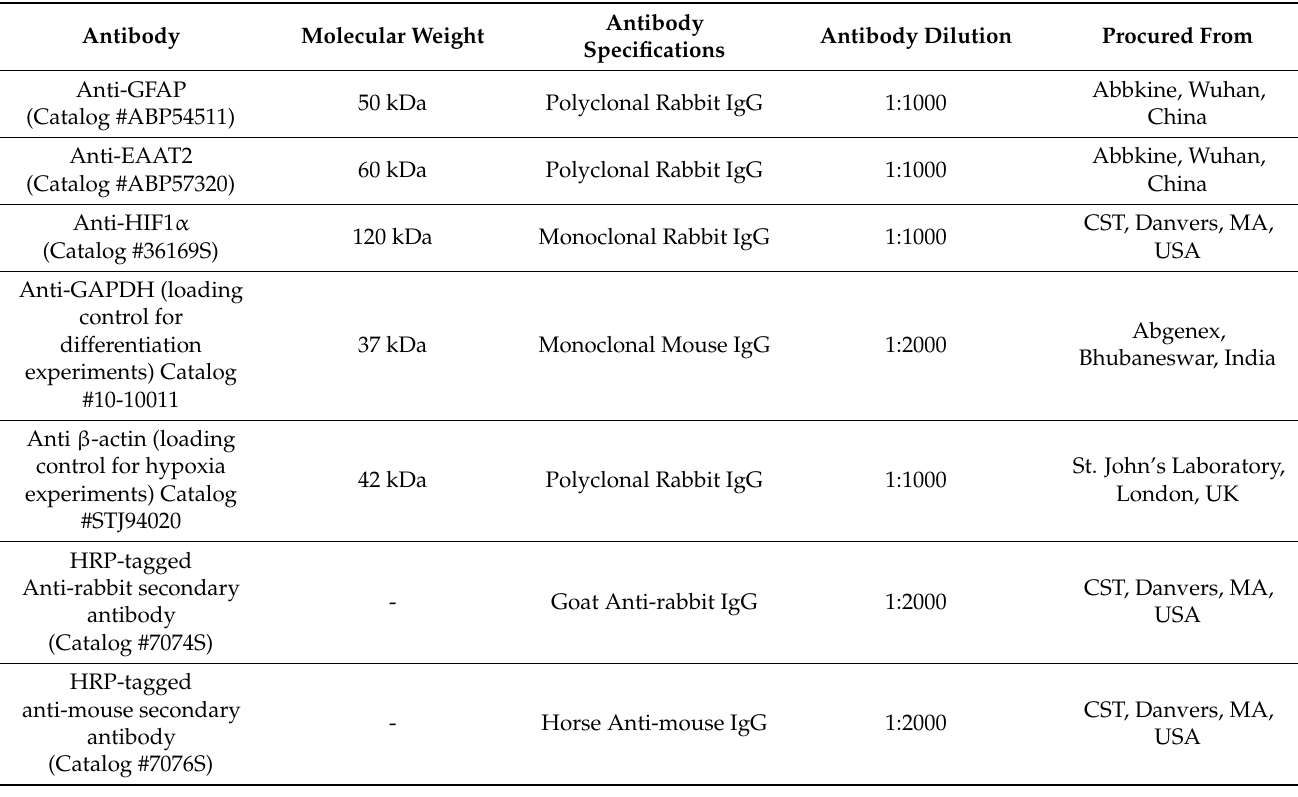
Table 2. Specifications for primary and secondary antibodies used for western blot